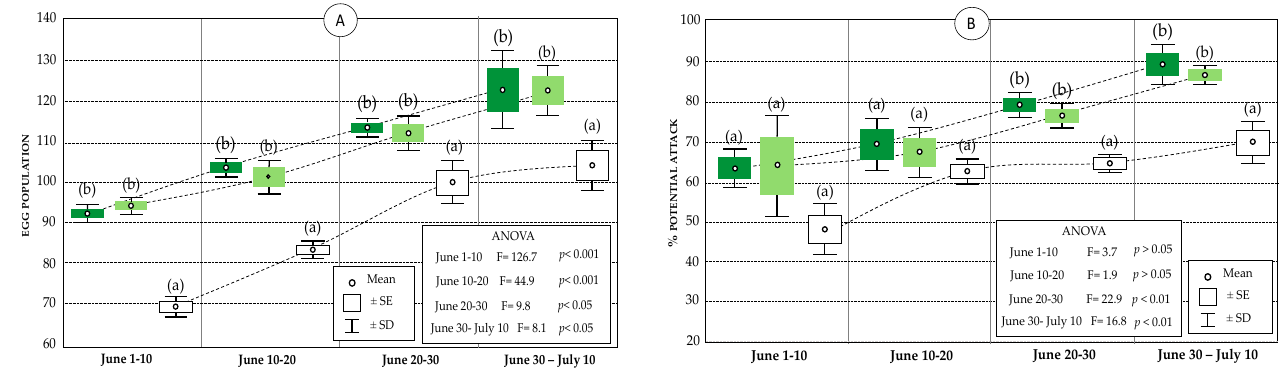
Figure 6. Statistics (mean, standard error, and standard deviation) of the population of P. oleae eggs in the olive groves subject to different management ( A ), and potential attack on the fruit ( B ) in VC-MIX (dark green), VC (light green), and conventional (white). Significant differences within each sampling interval are indicated by letters (Tukey’s HSD test, p < 0.05).